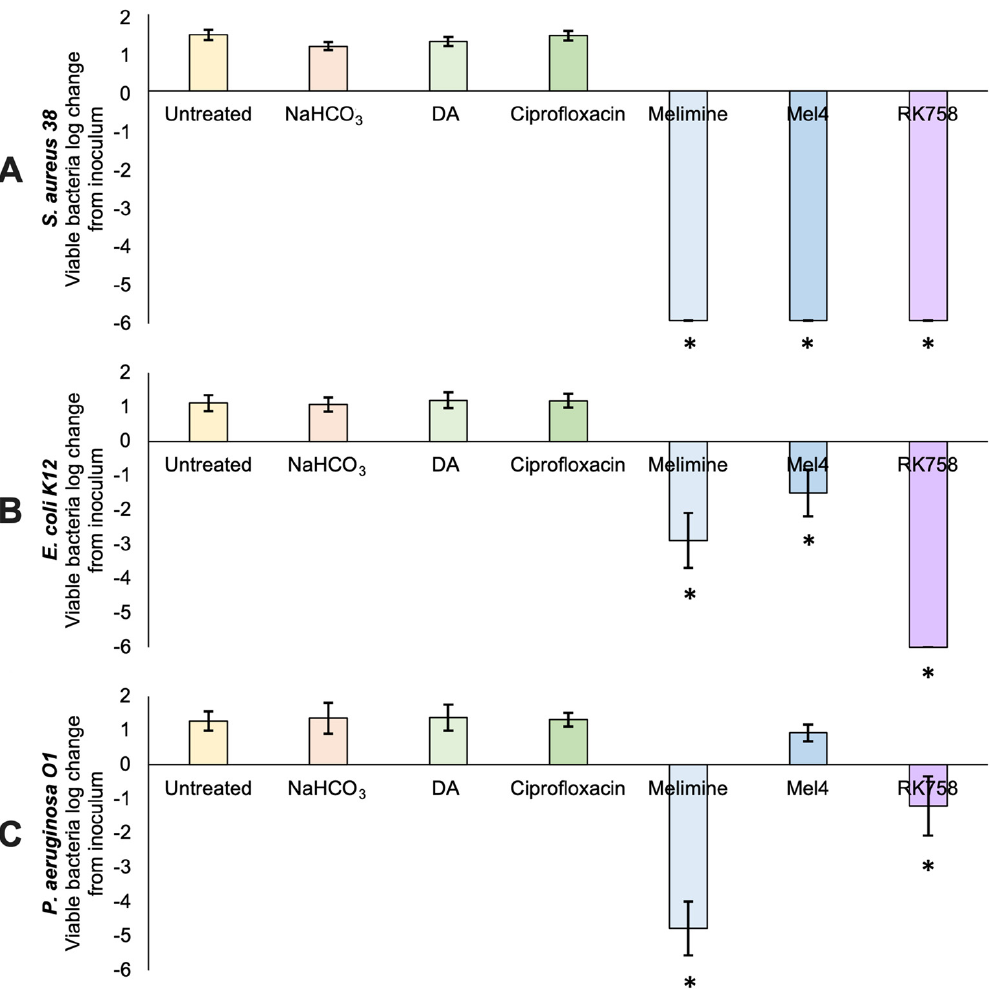
Figure 3. Antibacterial activity of coated surfaces. ( A ) Staphylococcus aureus 38. ( B ) Escherichia coli K12. ( C ) Pseudomonas aeruginosa O1. Data represent mean ± SD, n = 3. DA = polydopamine. Statistical analysis was conducted on GraphPad Prism v9 using a one-way ANOVA with Dunnett’s multiple comparisons test. * represents statistical difference to polydopamine (DA) treatment group, p <